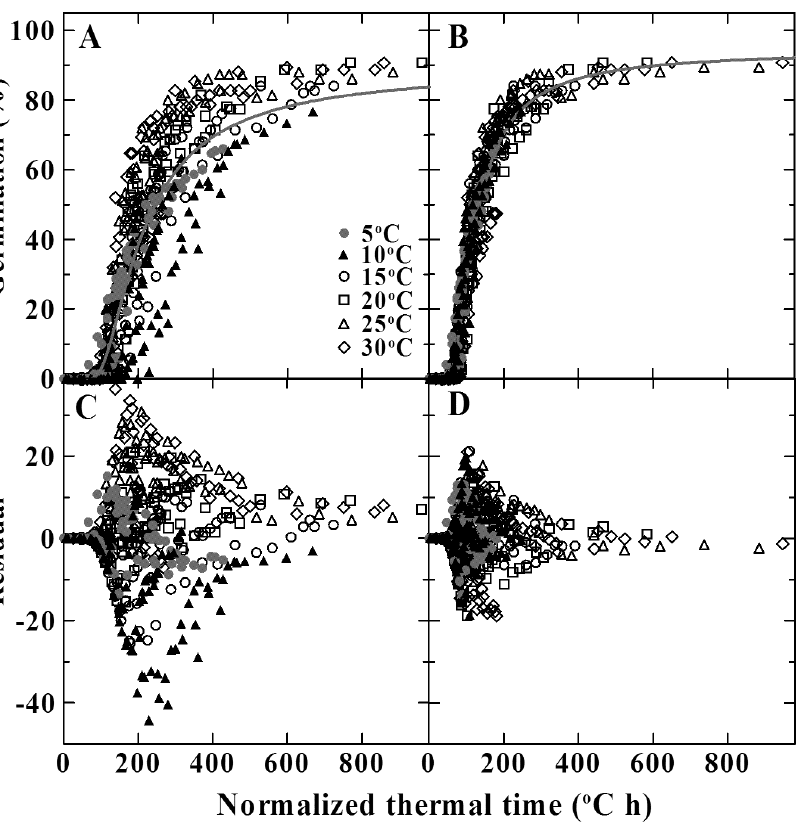
Figure 4. Normalized thermal time courses of seed germination at different temperatures and storage times. The time courses of germination at different temperatures and storage times were plotted on a normalized thermal time scale (A and B). These normalized thermal times were calculated according to equation (9) (A) and equation (9) and (14) (B) using the one-phased and two-phased model parameters in Table 3, respectively. Regression lines (gray lines) were plotted using a common set of constants in one-phased model (A), and using the parameters at 15– 30 u C in two-phased model (B) shown in Table 3. The residuals of the regressions were shown in C and D.